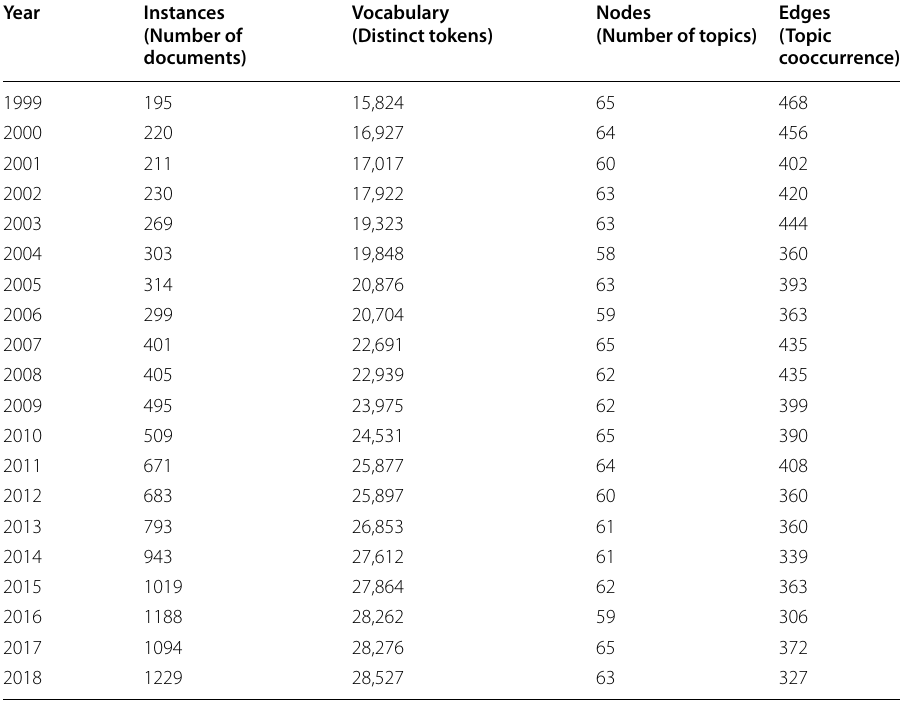
Table 2 lists the characteristics of the temporal network of associated topics, over the 20-year time series. The number of topics (or nodes) listed in Table 2 are those with at least one edge (or cooccurrence) with another topic. Hence, isolated topics not addressed with any of the 70 identified topics are not included in the number of nodes listed in Table